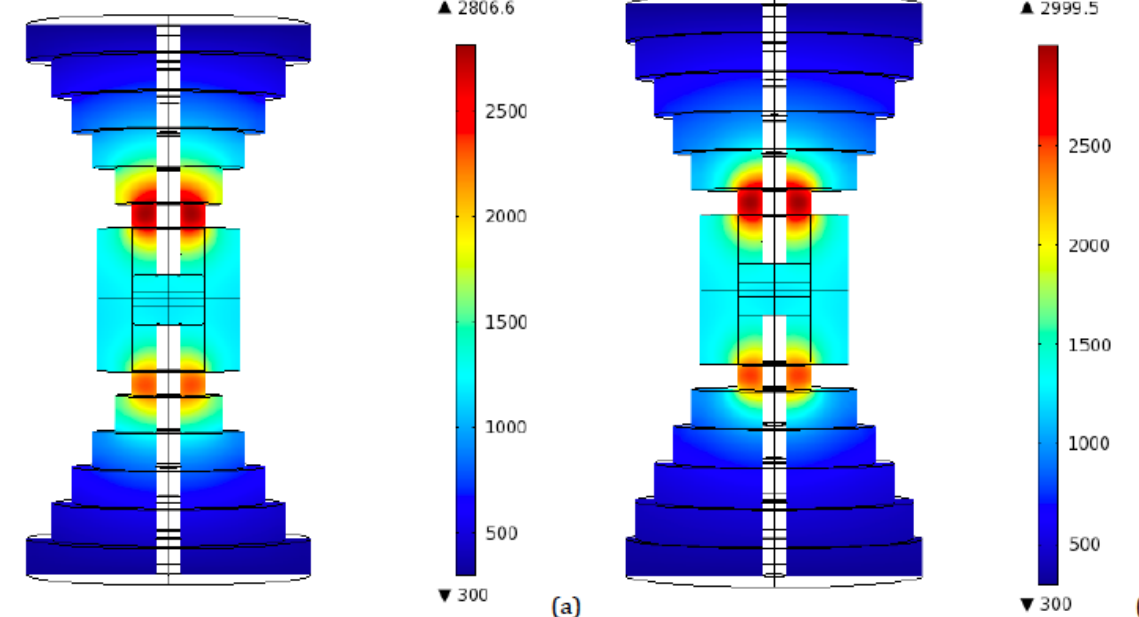
Figure 8. Peak temperature distribution (K)—Resistive contact—four transitional disks configuration. ( a ) Radii: 66, 54, 42, and 30 mm—Heights: 20 mm each; ( b ) Radii: 75, 65, 55, and 45 mm—Heights: 20 mm